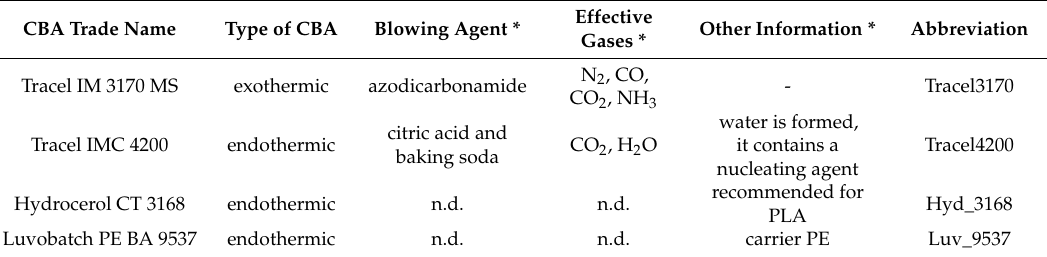
Table 1. Chemical blowing agents (CBAs) used and their properties.